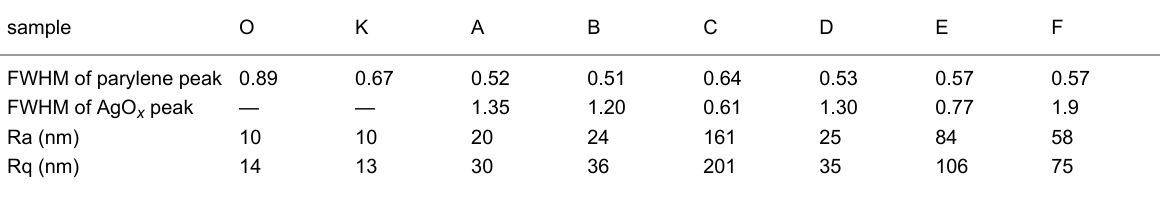
Table 2: XRD data and AFM roughness of NCPC samples: effect of Ag incorporation on the peak width (FWHM) and roughness (Ra, Rq) of the films.